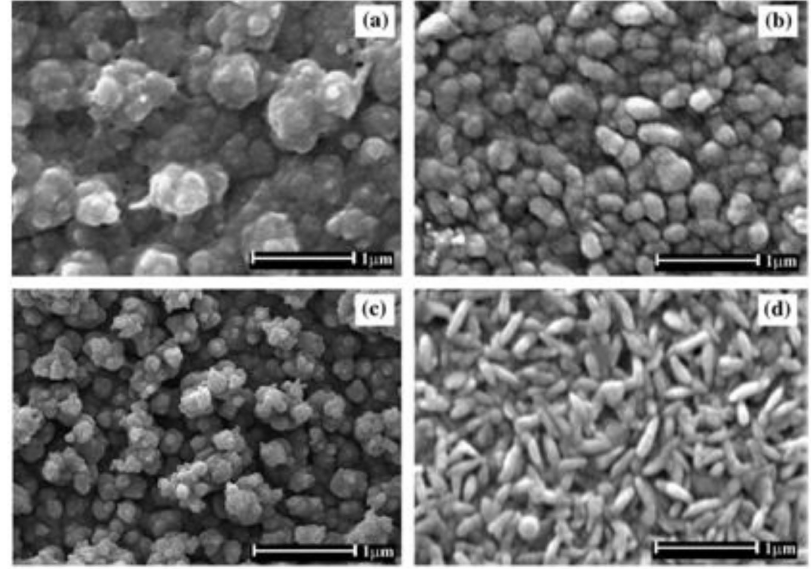
Figure 8. SEM photographs of Cr 1.8 Ti 0.2 O 3 films deposited at 650 -C from the different precursor without additive ( a ) 0.05 M, ( b ) 0.005 M, and with additive ( c ) 0.05 M, ( d ) 0.005 M. Reprinted from [85] with permission from Elsevier.